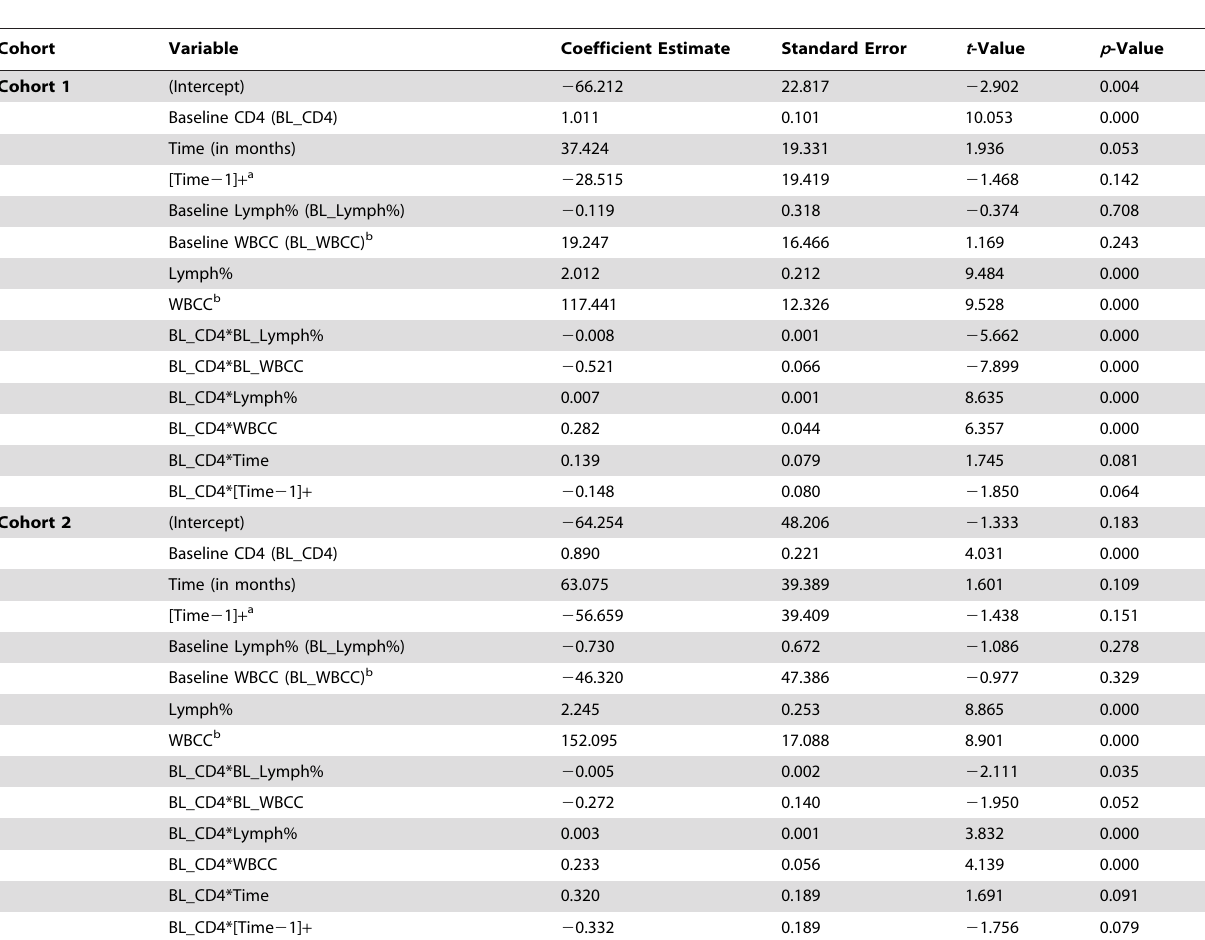
Table 3. Mixed-effects change-point modeling results for Cohort